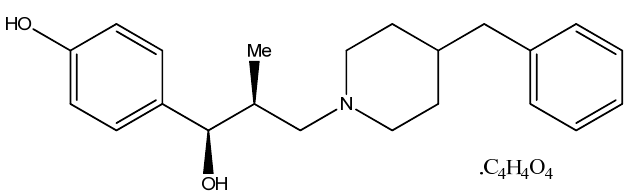
Figure 11. Ro 25-6981.